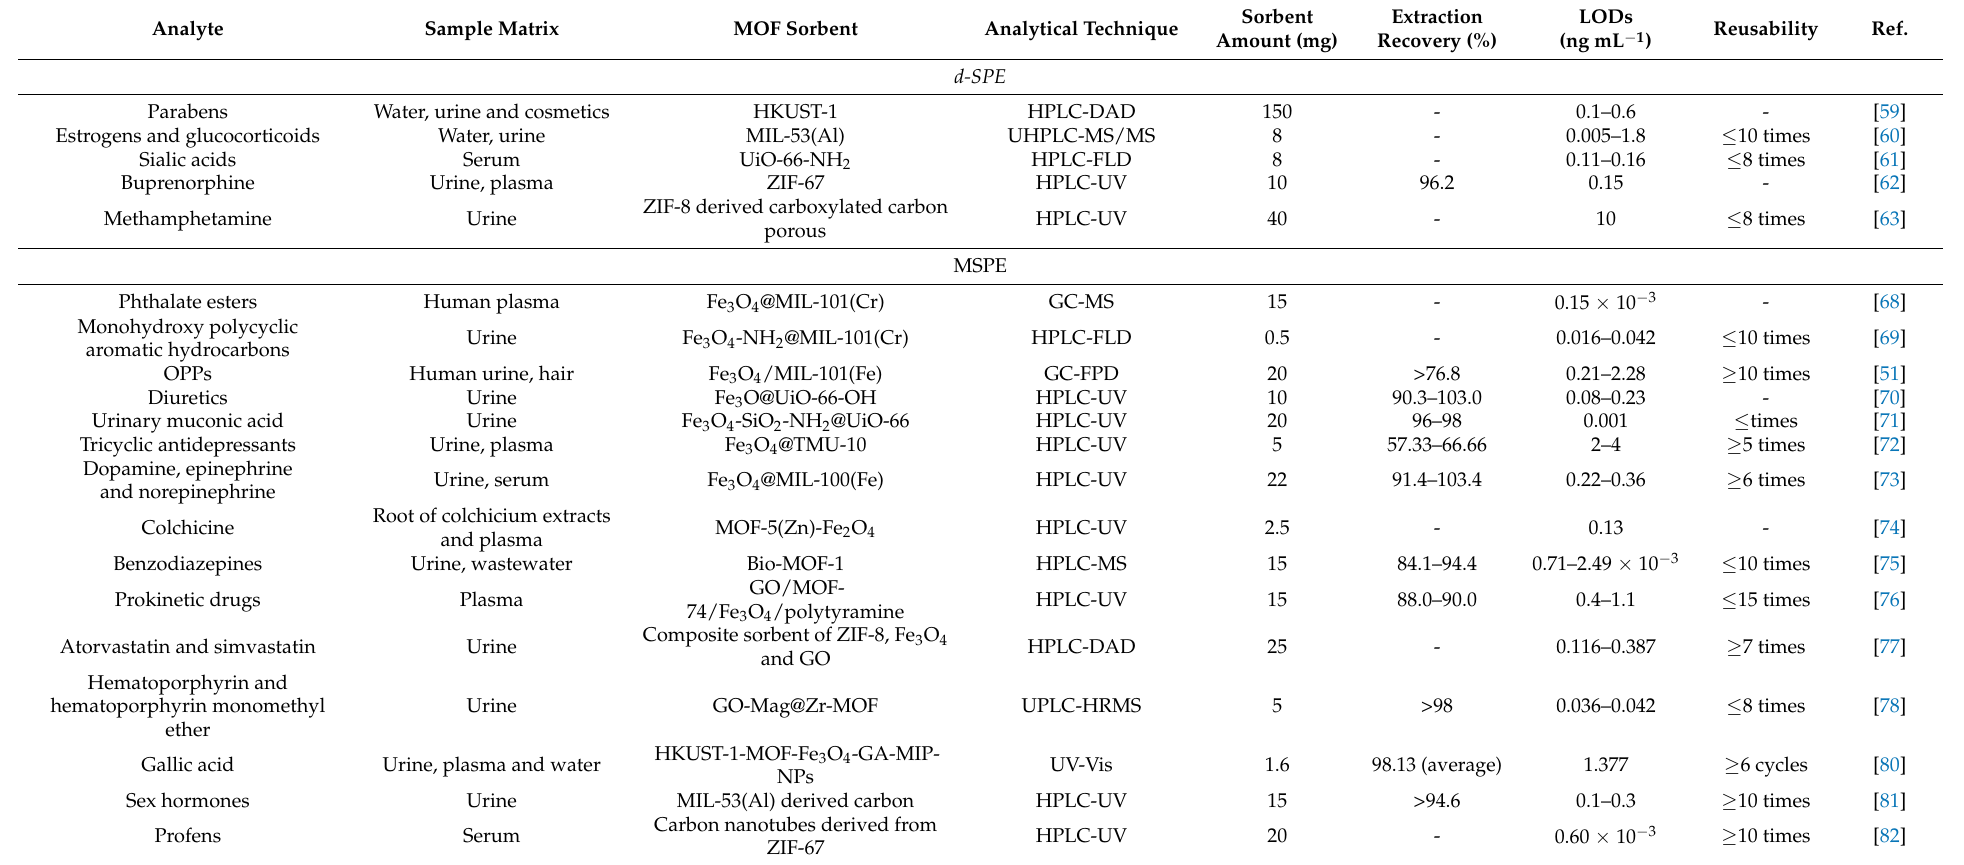
Table 1. Applications of MOFs in the determination of organic compounds in biological